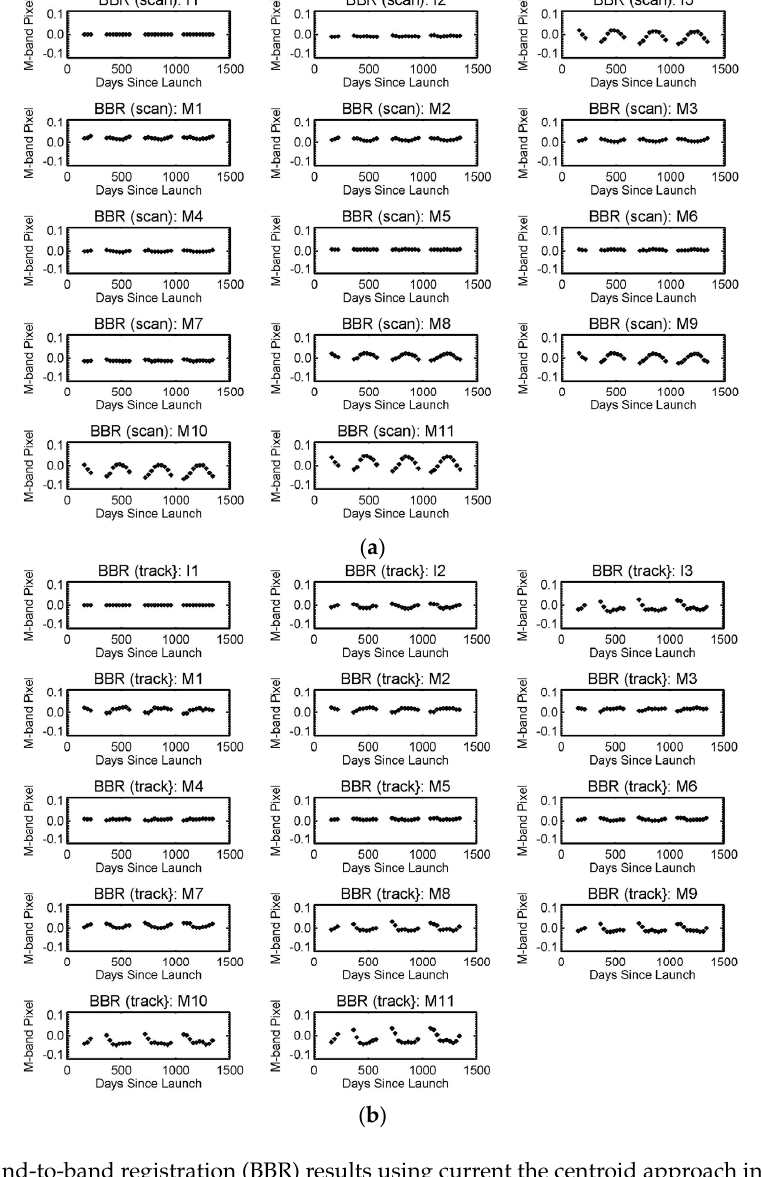
Figure 3. Band-to-band registration (BBR) results using current the centroid approach in both the ( a ) along-scan and ( b ) along-track directions, referenced to Band